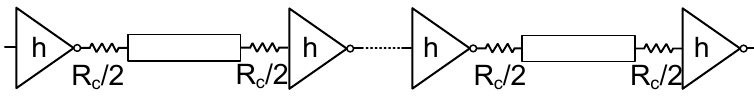
Figure 11. Repeater insertion in a long global nanocarbon interconnects.